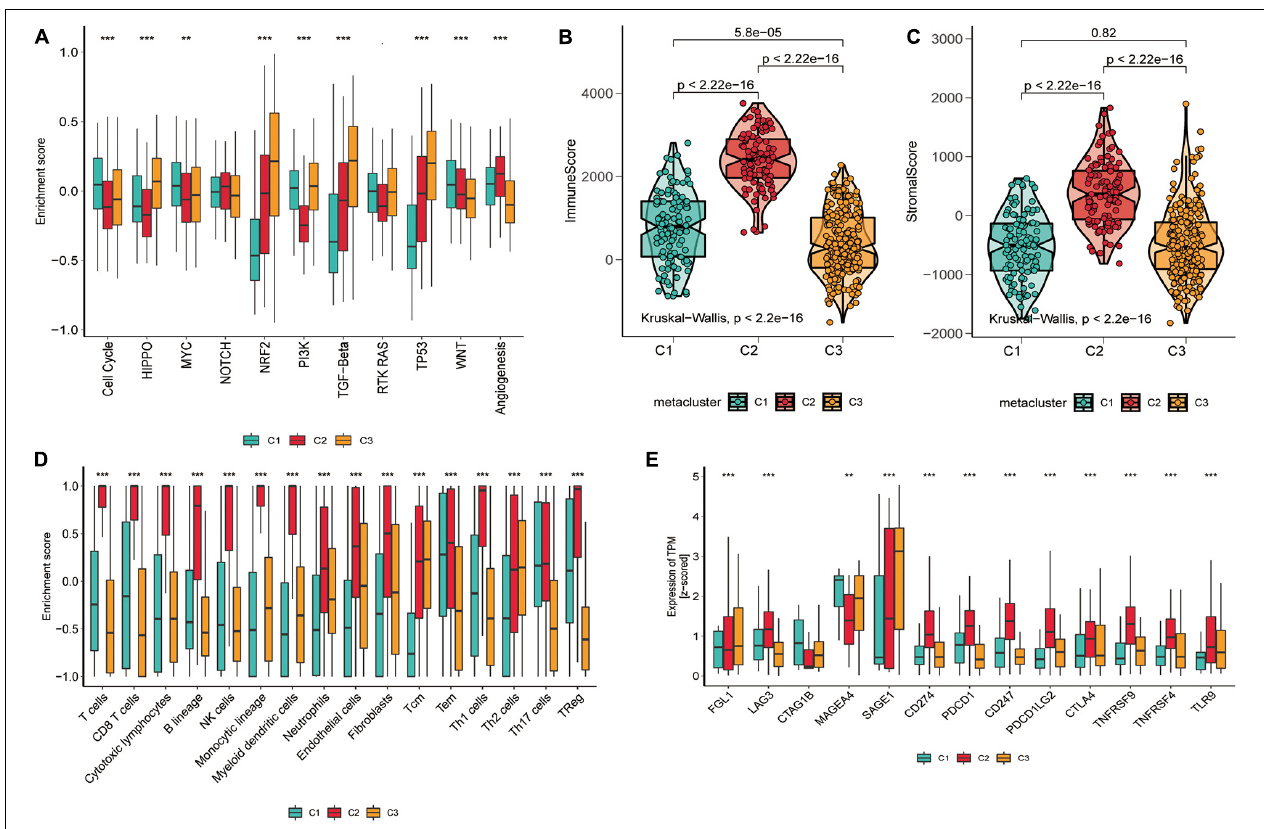
FIGURE 3 | Tumor microenvironment signatures of three subtypes in the TCGA-SKCM. (A) Box plots of characteristic marks discriminating different subtypes of SKCM progression-related features. Box-line plots of the immune score (B) and stromal score (C) estimate three subtypes. For the box-line plot, the lines in the box represent the median, the bottom, and top of the box, which are the 25th and 75th percentiles (interquartile range), and the vertical lines represent 1.5 times the interquartile range. Statistical differences were compared by the Kruskal–Wallis test, and p -values are marked with an asterisk above each box line plot (ns indicates no significance, ** p < 0.01, **** p < 0.0001). (D) The boxplot showed the accumulation of immune and stromal cell populations discriminated by different subtypes. (E) Expression level (normalized transcripts per million) of 14 immune checkpoint genes in three SKCM subtypes. The difference was verified statistically through the Kruskal–Wallis test, and the p-values are noted with asterisks at the top of each boxplot (ns stands for no significance, * p < 0.05, *** p <